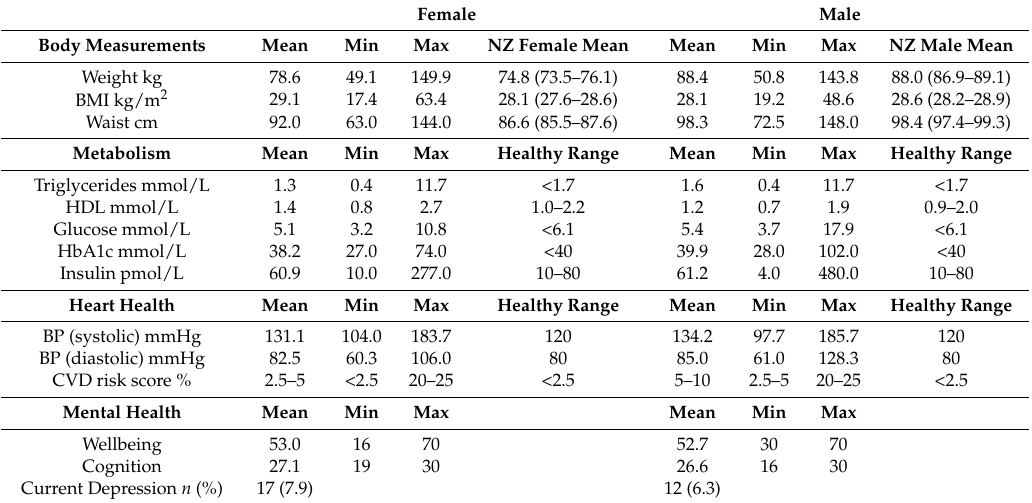
Table 2. Health of CHALICE participants and normal ranges for the New Zealand population.